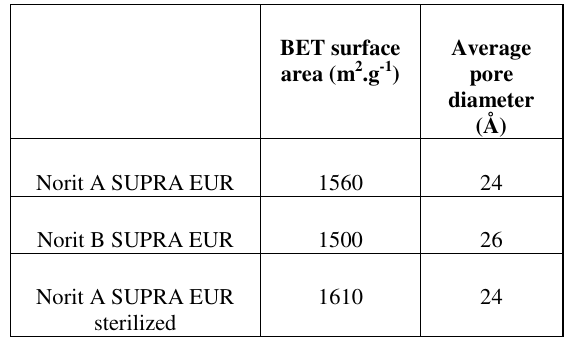
Table 1. Specific surface area and pore characteristics of AC